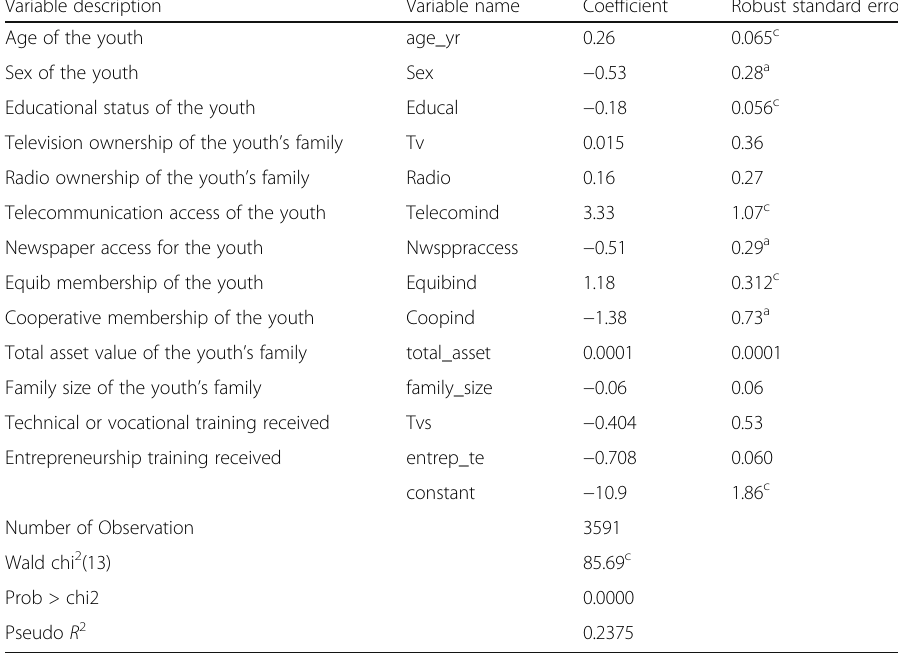
Table 10 Logistic regression result for covariates of self-employment Variable